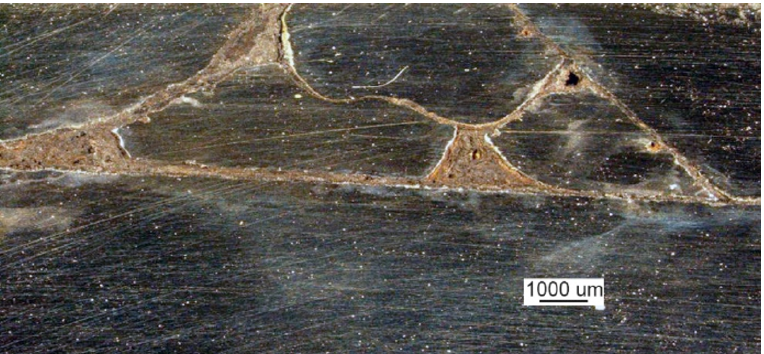
Figure 30. Degree of corrosion of crack I where it branches (handy-size bulk carrier 30210 DWT). Stereoscopic optical microscopy.